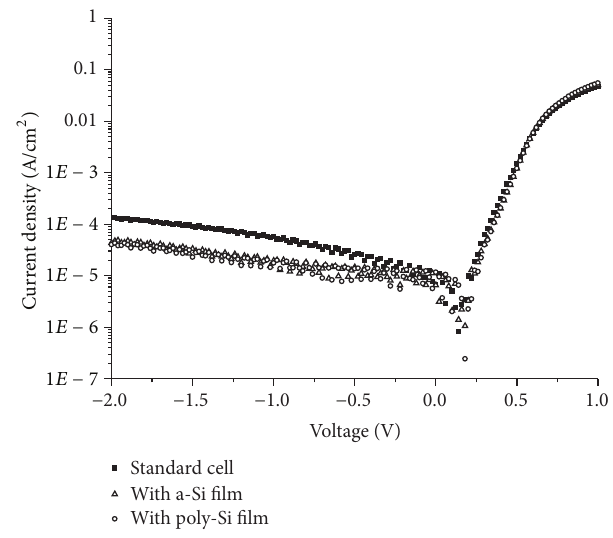
Figure 5: Comparison of dark log I - V plots of the standard cell ( ◼ ), solar cell with an a-Si film ( Δ ), and solar cell with a poly-Si film ( I ).